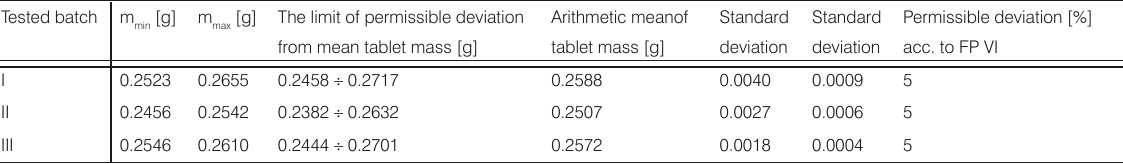
Table 2. The results the test of the produced tablets mass